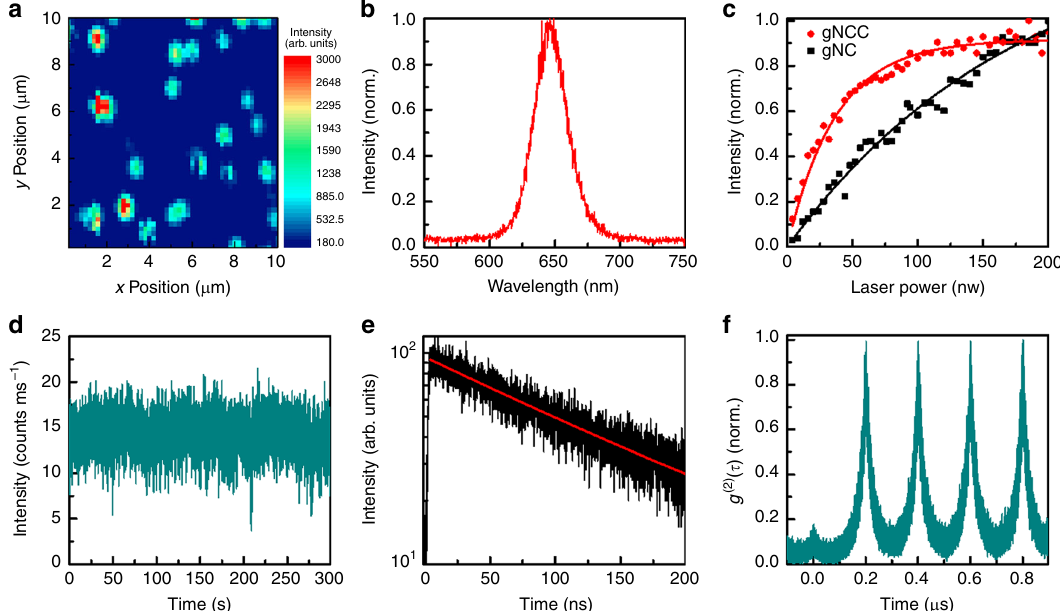
Fig. 2 Optical properties of single gNCCs at room temperature. a Confocal scanning PL image of single gNCCs. b PL spectrum of a single gNCC. c PL intensities measured as a function of the laser excitation powers for a single gNCC and a single gNC with the same CdS shell thickness of 20 MLs. These two sets of data points were normalized according to their respective maximum PL intensities obtained within the displayed laser power range. d PL intensity vs. time trace measured for a single gNCC with a time resolution of 10 ms. e PL decay curve measured for a single gNCC and fi tted with a